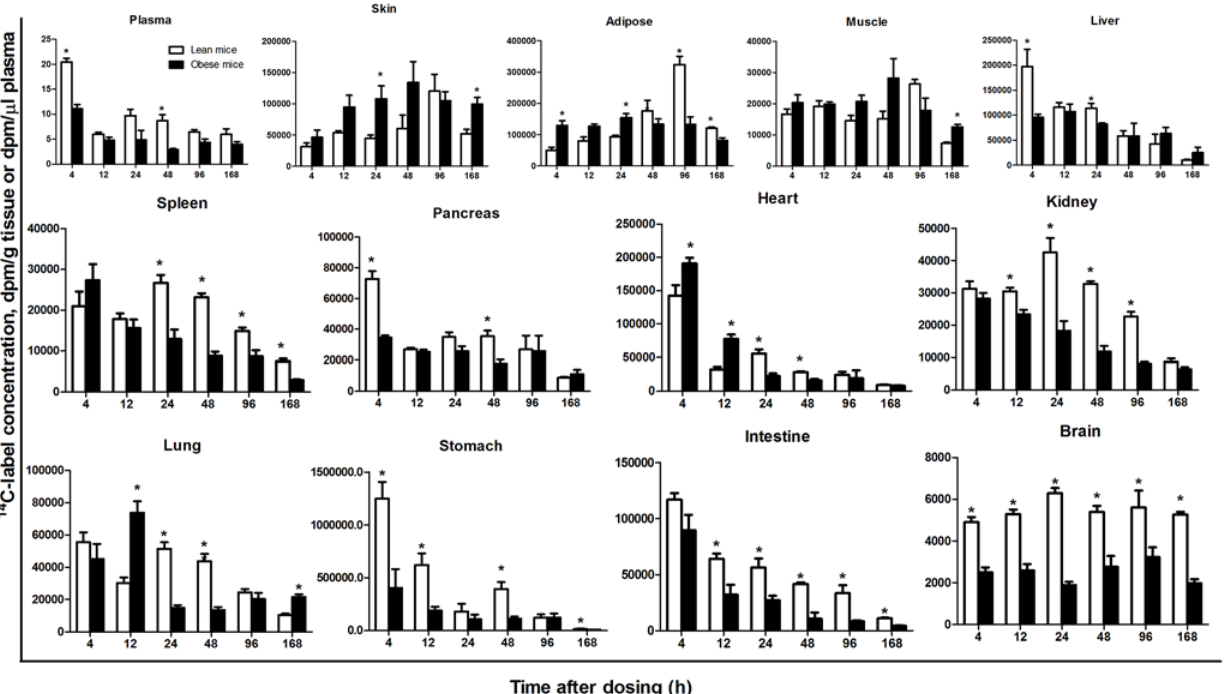
Fig 2. Time course (0 – 168 h) of the 14 C-label concentrations (dpm/g tissue and dpm/ μ l plasma) in plasma, skin, liver, muscle, adipose tissue, spleen, pancreas, heart, kidney, lung, stomach, intestine and brain from lean and obese mice after a single oral dose. The data are presented as the mean ± SEM (n = 3). Asterisks ( * ) indicate significant differences between lean and obese mice at a particular time point ( P < 0.05). Muscle: all harvested muscles from the arms and legs as well as dorsal muscle. Adipose: subcutaneous, visceral, perirenal and mesenteric adipose tissue.